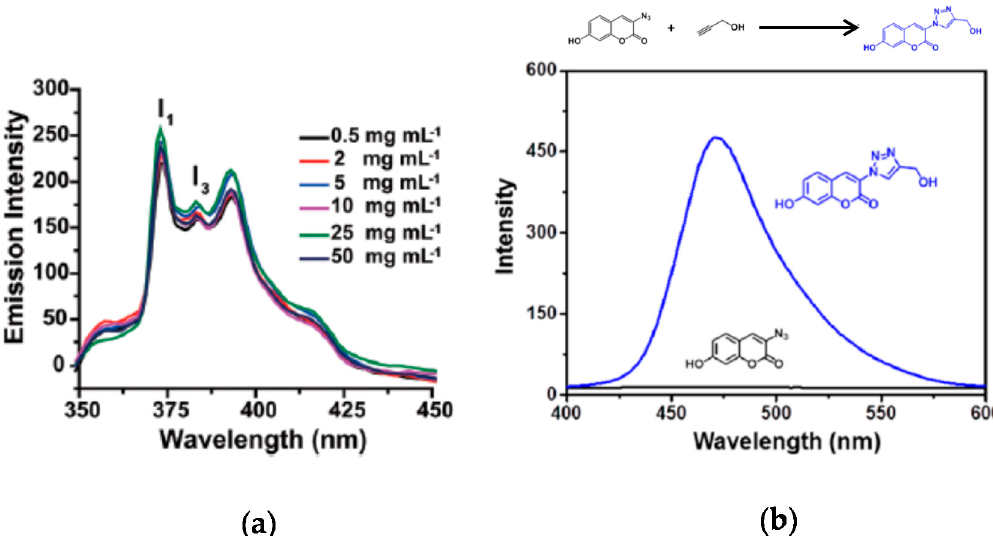
Figure 5. Emission spectra of pyrene sequestered into non-fluorescent SCNPs as a function of the concentration of SCNPs ( a ), and synthesis of a fluorescent compound into non-fluorescent Cu(I)-containing SCNPs via Cu(I)-catalyzed azide-alkyne cycloaddition of 3-azido-7-hydroxycoumarin and propargyl alcohol ( b ) (reprinted with permission from [38], Copyright Royal Society of Chemistry, 2015 and [39], Copyright American Chemical Society, 2015, respectively).